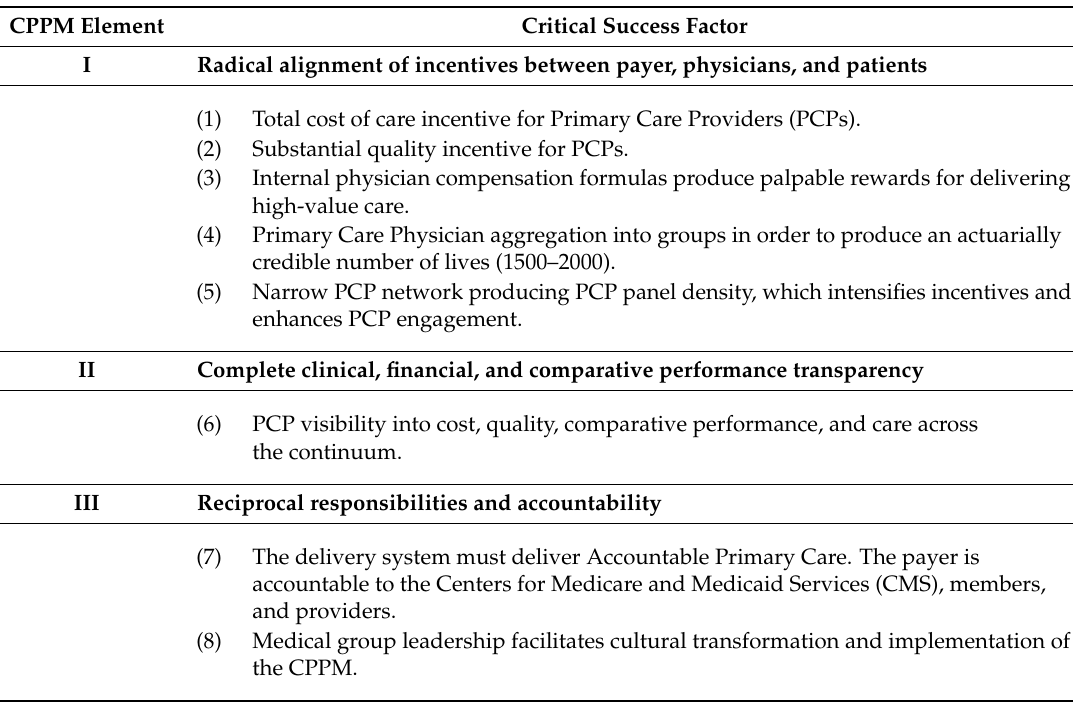
Table 1. The Collaborative Payer Provider Model (CPPM)’s three main elements and eight critical success